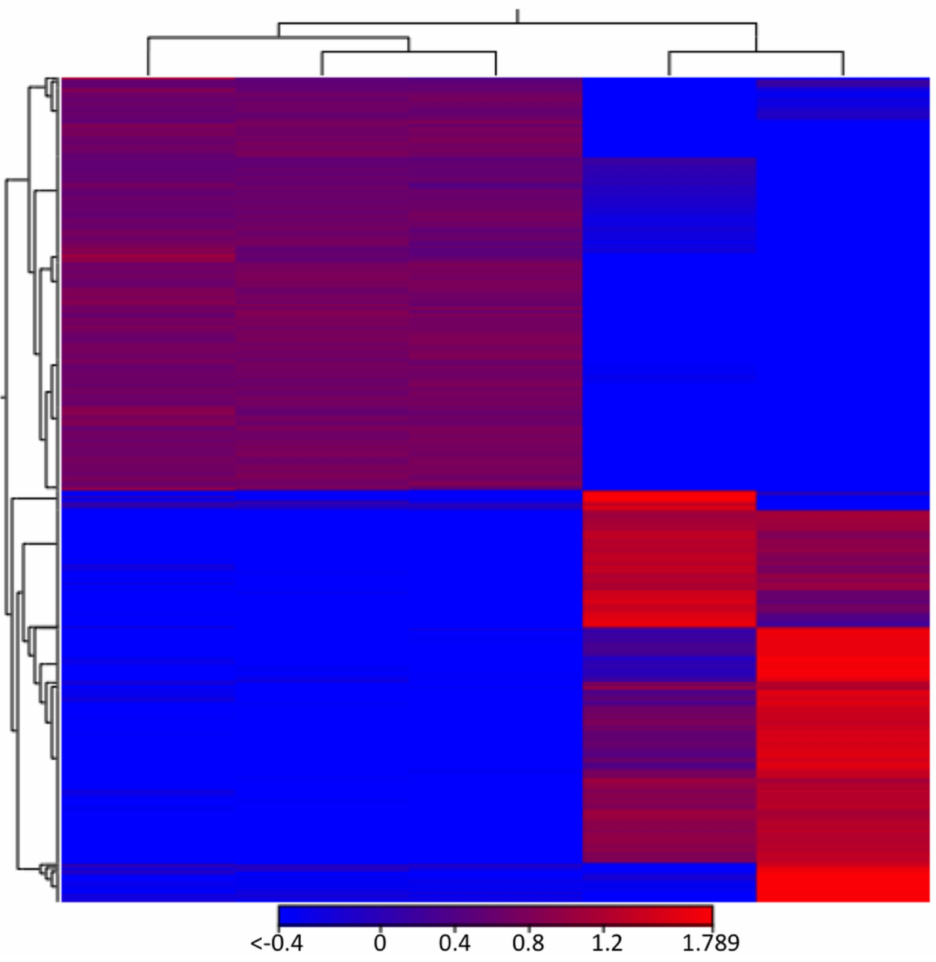
Figure 6. Heat map illustration of the comparison between cellular and EV RNAs. The expression levels are visualized using a gradient color scheme, where the red color is used for high expression levels and the blue color is used for low expression levels. Each line corresponds to a gene of the C. neoformans H99